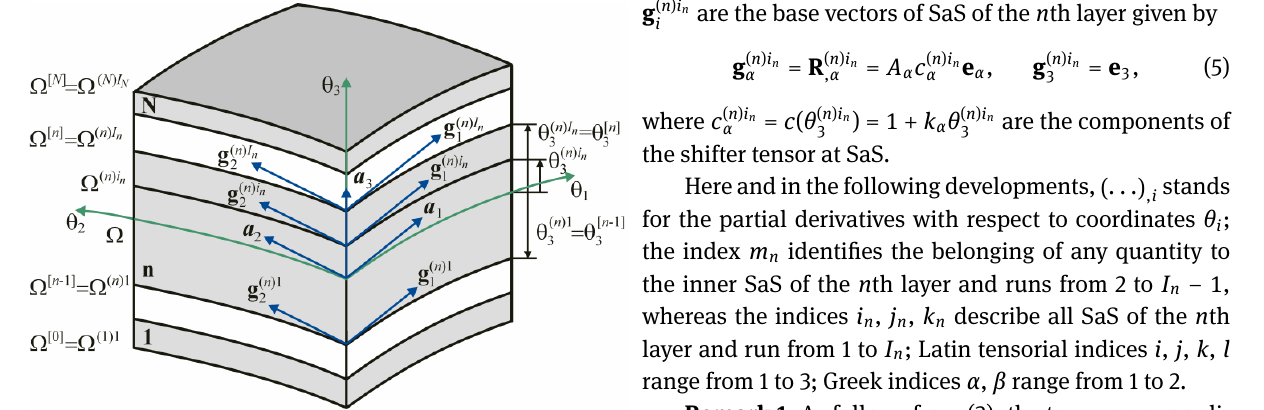
Figure 1: Geometry of the layered shell.